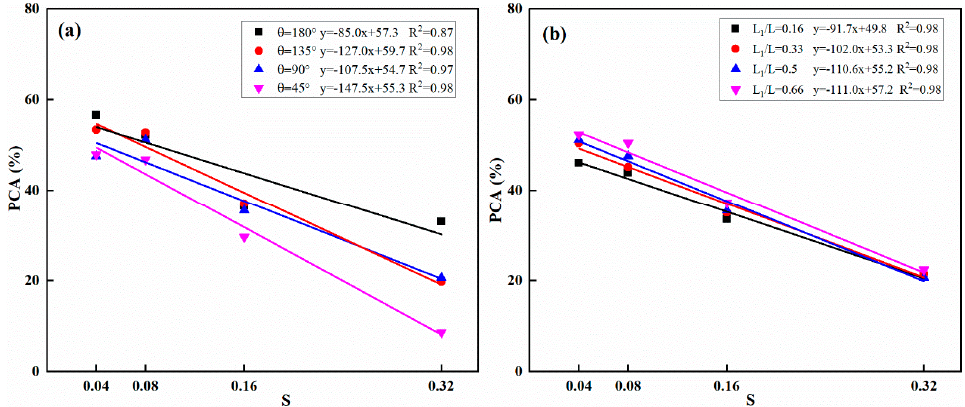
Figure 16. Snapshots of 70/140 mesh sand dunes in four channels at the stable status at Re = 3311 and θ = 90°, front view: ( a ) L 1 /L = 0.16; ( b ) L 1 /L = 0.33; ( c ) L 1 /L = 0.5; ( d ) L 1 /L = 0.66.